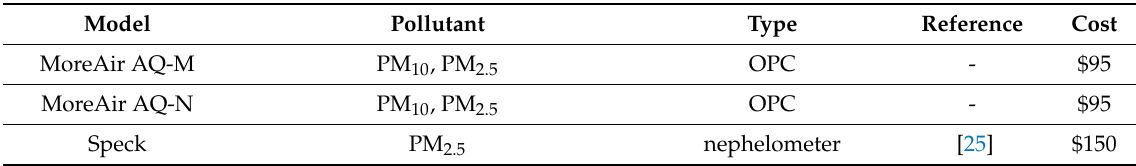
Table 1. Shortlist of sensor systems by pollutant, type, reference and